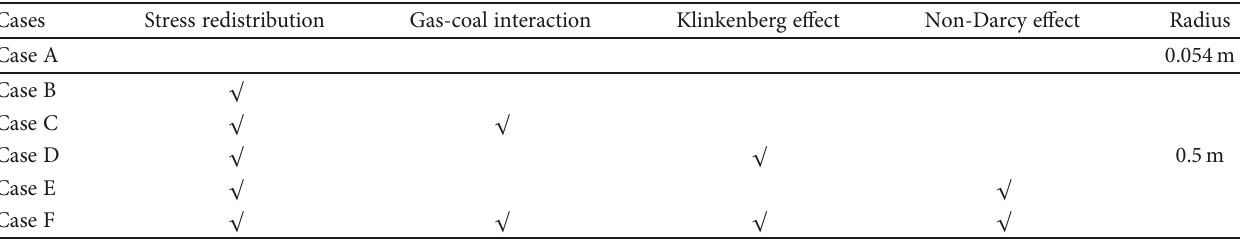
Table 1: Numerical simulation